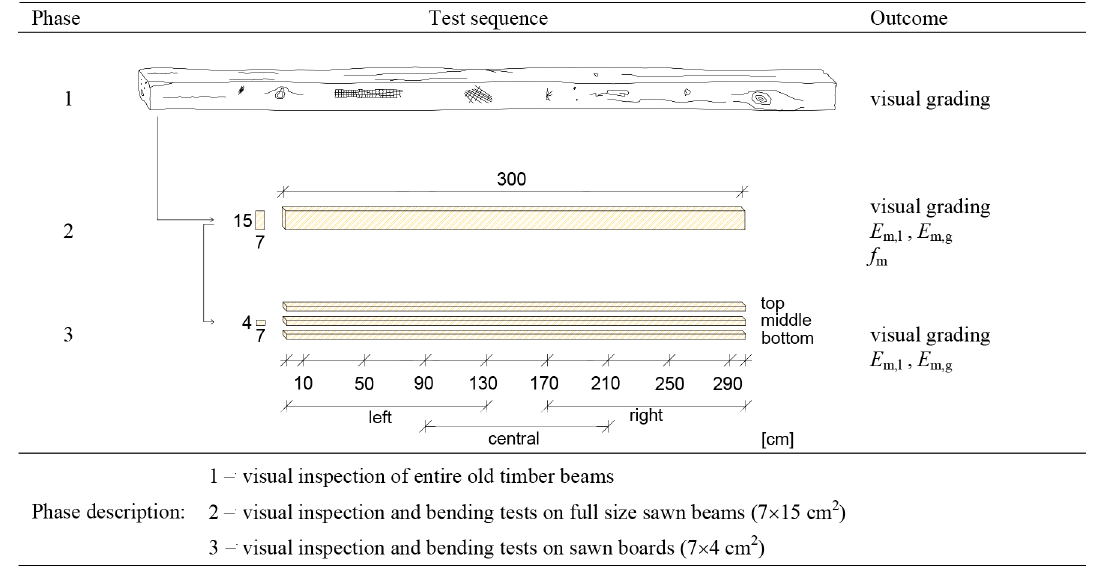
Fig. 1. Testing phases and results obtained for each